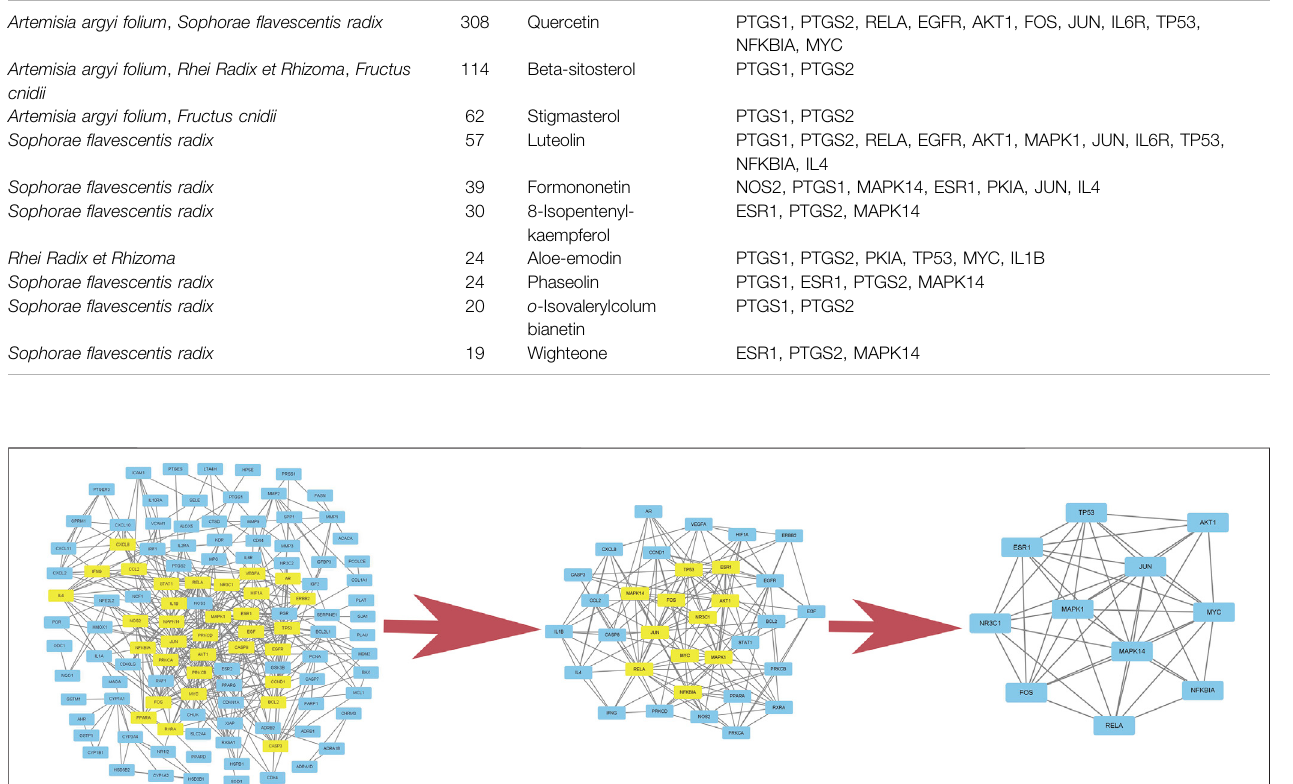
Table 2 . The targets (RELA, NFKBIA, MYC, MAPK1,